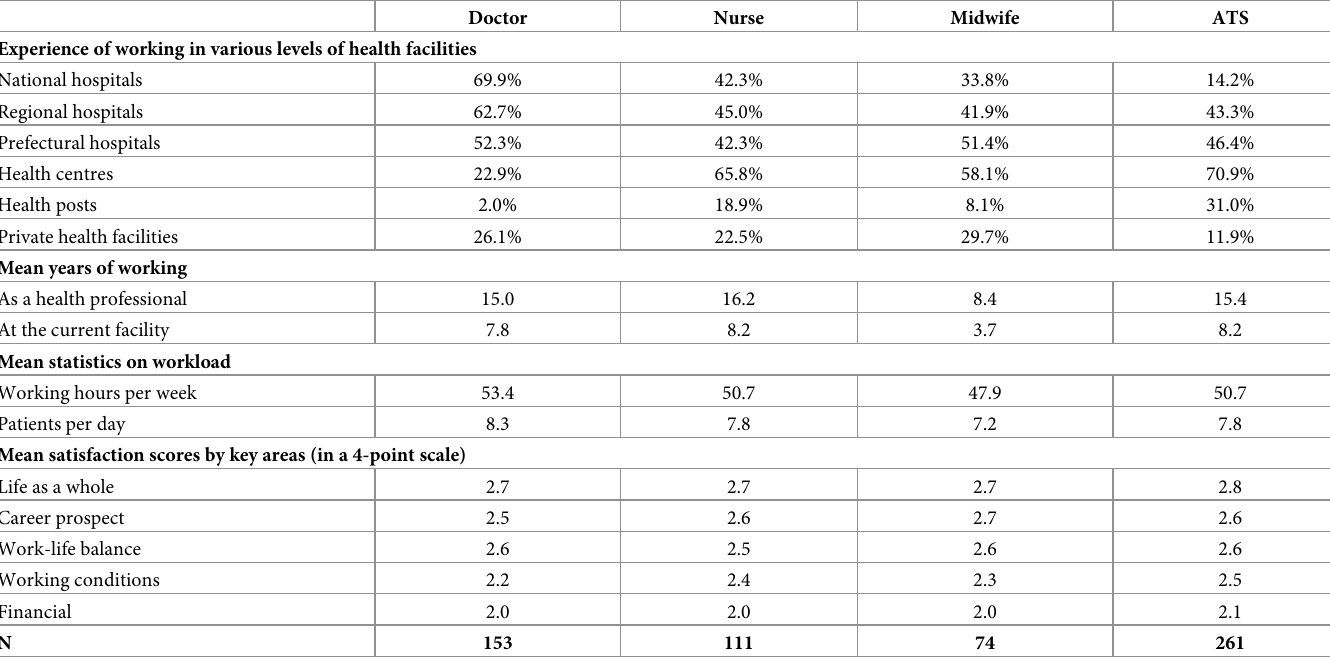
Table 2. Key characteristics of the health workers, by type.